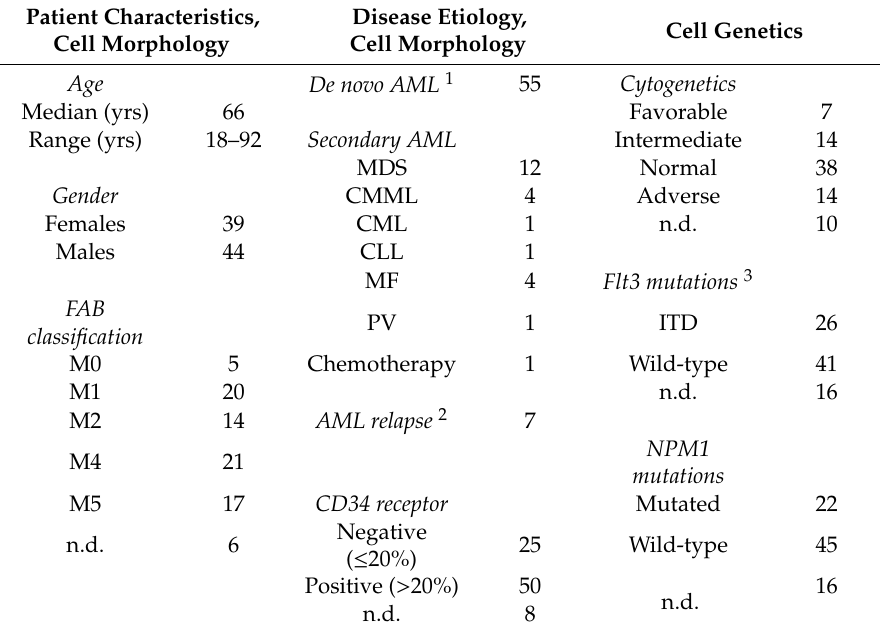
Table 4. Biological and clinical characteristics of the 83 AML patients included in the study. Patient